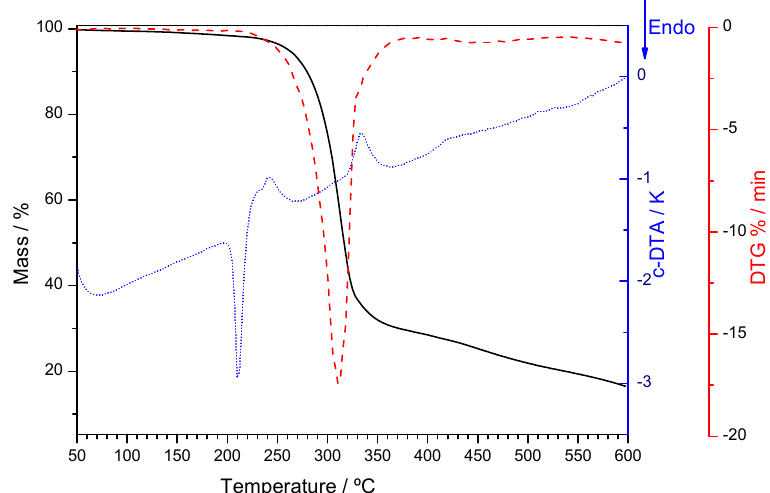
Figure 11. Thermogravimetric curve (solid black line), derivative thermogravimetric curve (dashed red line) and DTA heating curve (dotted blue line) of (1:2) TMP:THEO co-crystal. The crystalline structure of a (1:2) TMP:THEO (17% H 2 O) was solved (CCDC 2109486)